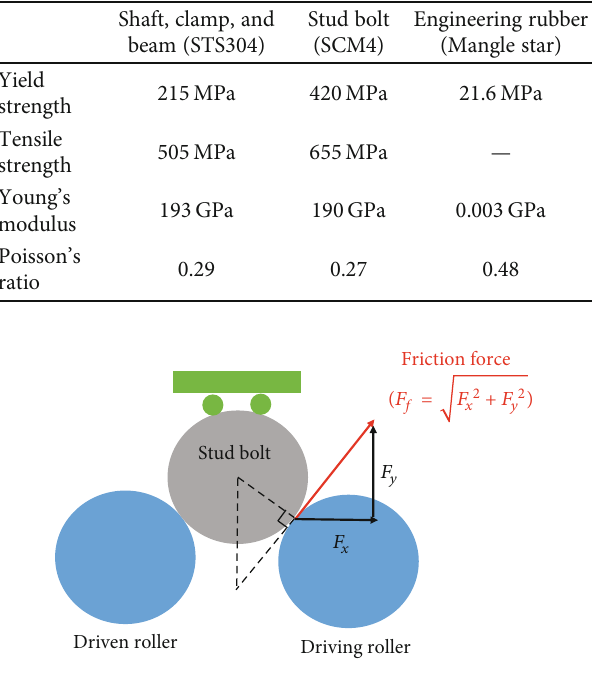
Figure 9: Component of friction force. Table 2: Reaction forces at the contact area according to the clamp load (unit: N).